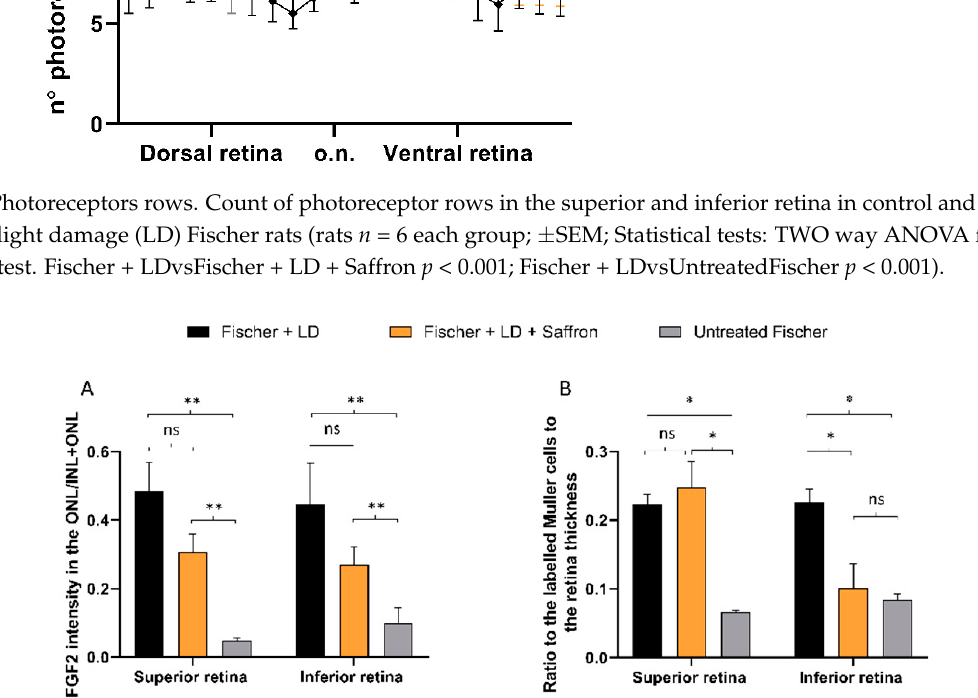
Figure 6. FGF2 and GFAP modulation by Saffron treatment of Fischer rats. ( A ) Quantification of FGF2 positive pixels in the ONL respective to the total amount in the retina layers. The graph bar shows no significant reduction of the FGF2 expression in treated rats (orange) compared to the LD control (black). ( B ) Quantification of GFAP positive Müller cell branches normalized to retinal thickness. The graph bar shows a significant reduction of the GFAP ratios in the inferior retina of Fischer treated rats (orange) compared to the relative LD control (black). ( n = 6; ±SEM; Statistical tests: One way ANOVA followed by Dunnett’s test) significance indicator: n.s. p > 0.05; * p < 0.05; ** p < 0.01.